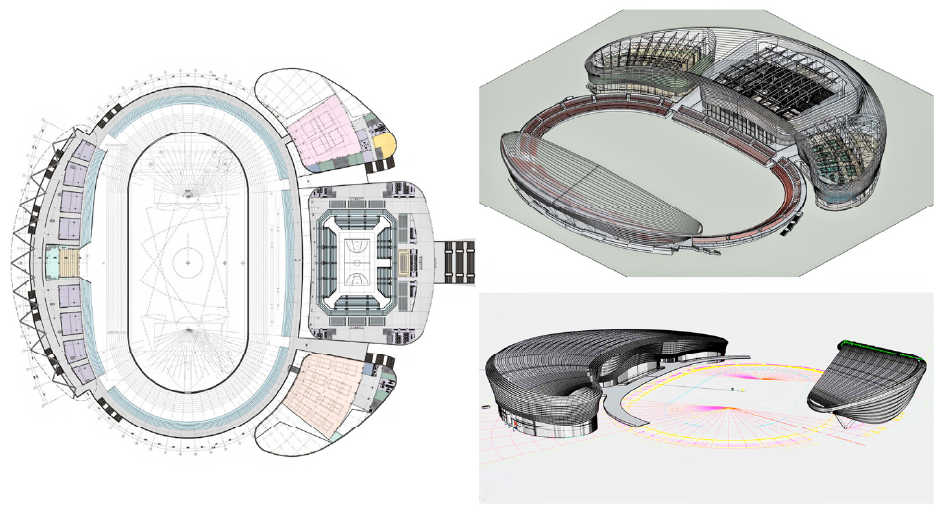
Figure 3. The main BIM model of the composite stadium project.